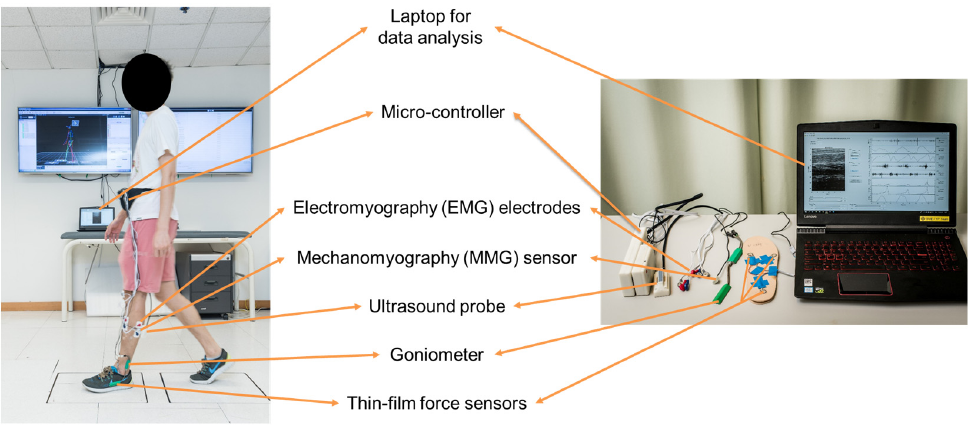
Figure 1. The wearable ultrasound imaging and sensing